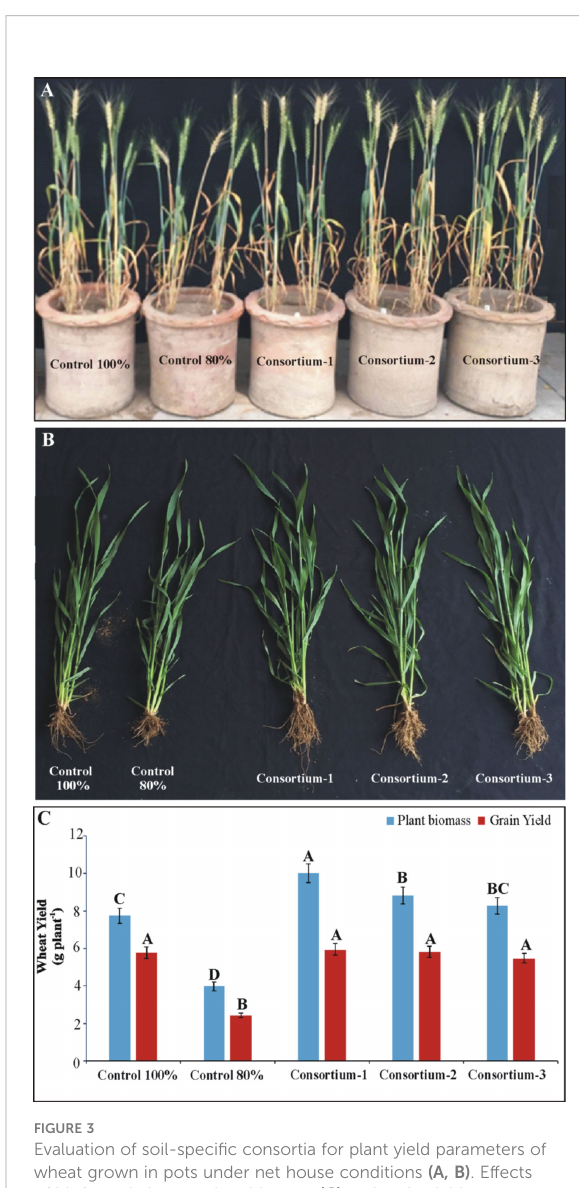
FIGURE 3 Evaluation of soil-speci fi c consortia for plant yield parameters of wheat grown in pots under net house conditions (A, B) . Effects of bioformulation on plant biomass (C) and grain yield were recorded. Mean values denoted by the same letter are not signi fi cantly different at P = 0.05 according to